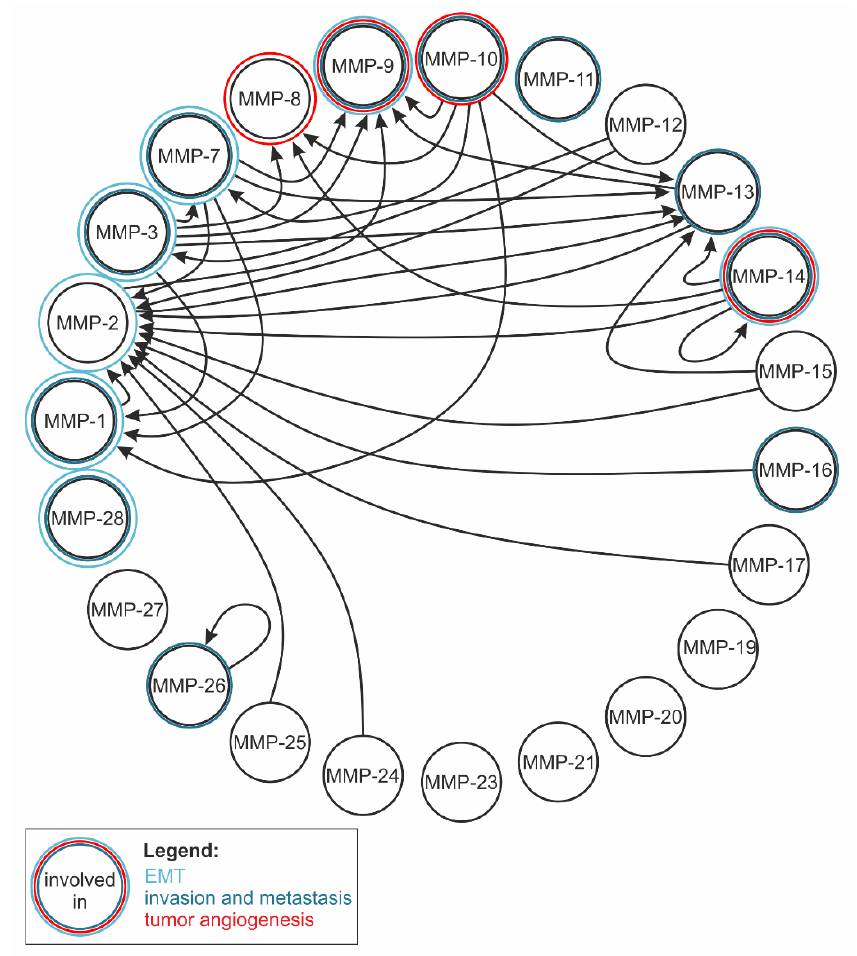
Figure 3. Mutual activation of the MMPs expressed in humans. In cancer, many of these MMPs are involved in EMT, invasion, and metastasis, as well as tumor angiogenesis. The mutual MMP-mediated activation of the human MPPs at the protein level is indicated by arrows. Participation in EMT, invasion, and metastasis as well as tumor angiogenesis is color coded. There is also a mutual influence on the transcription level, as explained in the text. Nearly all of the MMPs in the upper half of the figure are strongly involved in cancer progression, but, also, all the others are relevant to at least some cancers. References are in the text and in Table 1.